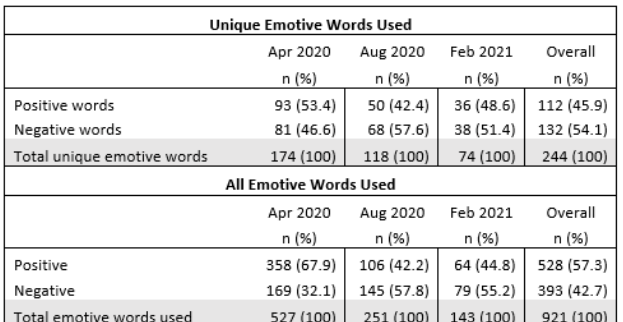
Table 3 Sentiment analysis of free-text responses to each survey. Both the number of uniquely used words and the total number of words used with positive and negative sentiments are captured.